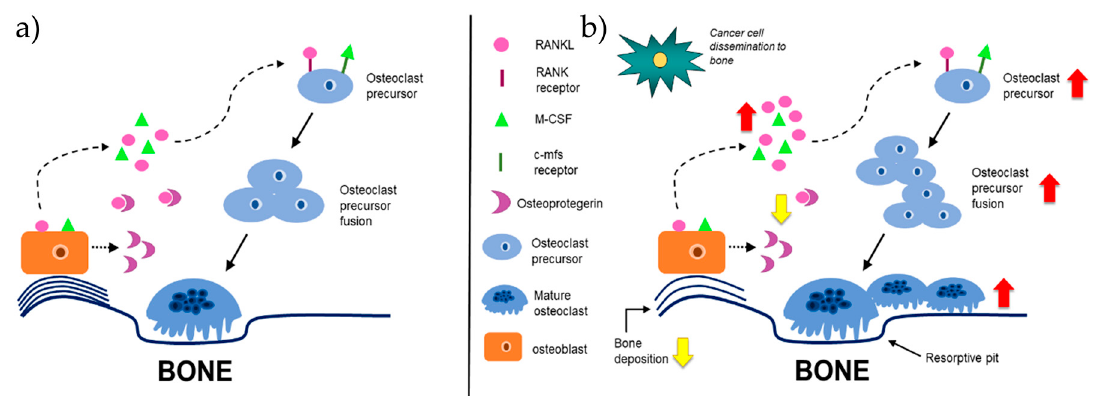
Figure 4. The bone matrix is manipulated to promote cancer growth. ( a ) The bone matrix is comprised of organic and inorganic components. The main organic component of the bone matrix is collagen type I. The bone matrix is also comprised of non-collagenous proteins, including fibronectin, lysyl oxidase (LOX), a crosslinker of collagen, and matrix metalloproteinases (MMPs), degraders of the bone matrix. Inorganic bone matrix components include hydroxyapatite crystals, which allow for mineral exchange in bone. To combat excess bone degradation, osteoblasts secrete osteoprotegerin (OPG), a decoy receptor for soluble receptor activator of nuclear-factor kappa- β ligand (RANKL). OPG will bind the soluble RANKL and inhibit it from binding to the RANK receptor on osteoclast progenitors. Debris from bone resorption is removed and osteoblast progenitors are recruited to the resorption site, where they differentiate into osteoblasts, and secrete bone-forming molecules. Osteoblasts secrete organic components, including collagen type I and non-collagenous proteins, including proteoglycans, that aid in new bone formation. In this way, bone homeostasis is maintained with little net gain or loss of bone composition. ( b ) Cancer cells initiate osteoblasts to secrete excess RANKL. Secreted RANKL binds to the RANK receptor on osteoclast progenitor cells to initiate differentiation. Increases in mono-nucleate osteoclast precursors cause more fusion and initiate increased production of multi-nucleate, mature osteoclasts. Due to increases in mature osteoclast formation, there is an increase in bone degradation. Additionally, OPG secretion decreases from osteoblasts. Therefore, there is less OPG to bind soluble RANKL, contributing to the indirect increase of osteoclast differentiation. The introduction of cancer cells into the bone microenvironment disrupts communication between osteoblasts and osteoclasts.